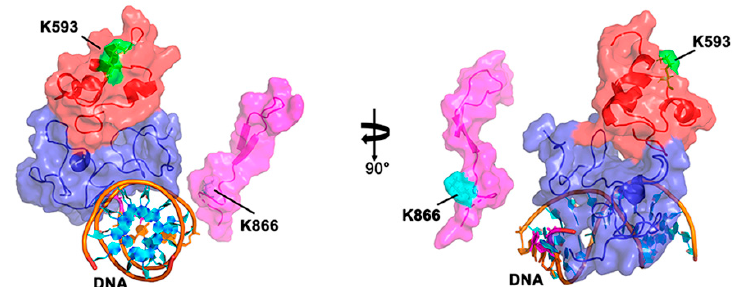
Figure 3. Schematic illustration of the role of insertions 1 and 3 of AtPOLIB in TLS. Homology model showing a close view of AtPOLIB in complex with a dsDNA substrate. This homology model was constructed using the molecular operating environment (MOE) software and as a template, the crystal the structure of Bacillus DNAP bound to dsDNA (PDB: 4DSE) [34,65]. This model shows that insertions 1 and 3 are in an optimal position to interact with dsDNA and highlights the relative positions of insert 1 (red-colored) and insert 3 (pink-colored) poised to clamp DNA. The localization of residues K593 and K866 located in insertions 1 and 3 respectively, are